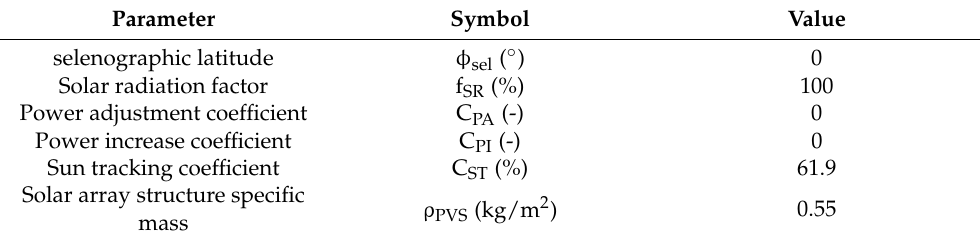
Table 9. Parameters of the baseline